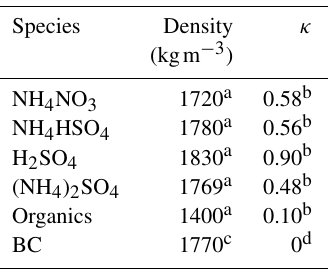
Table 1. The density and the κ value of the related species used in this